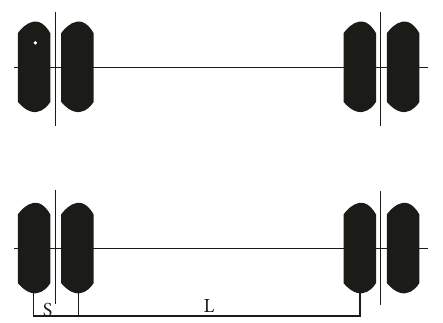
Figure 4: Schematicillustration of the structureof A-type transport aircraft main